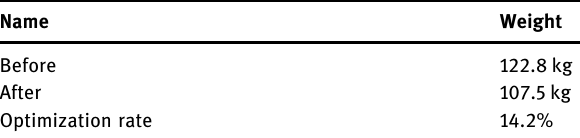
Table 6: Results of the mass optimization Table 7: Parameters of the candidate materials for cost